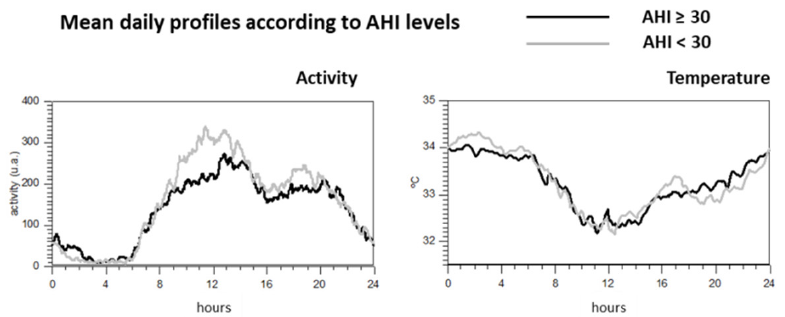
Figure 1. Mean daily profile of the activity and wrist temperature according to the levels of AHI.